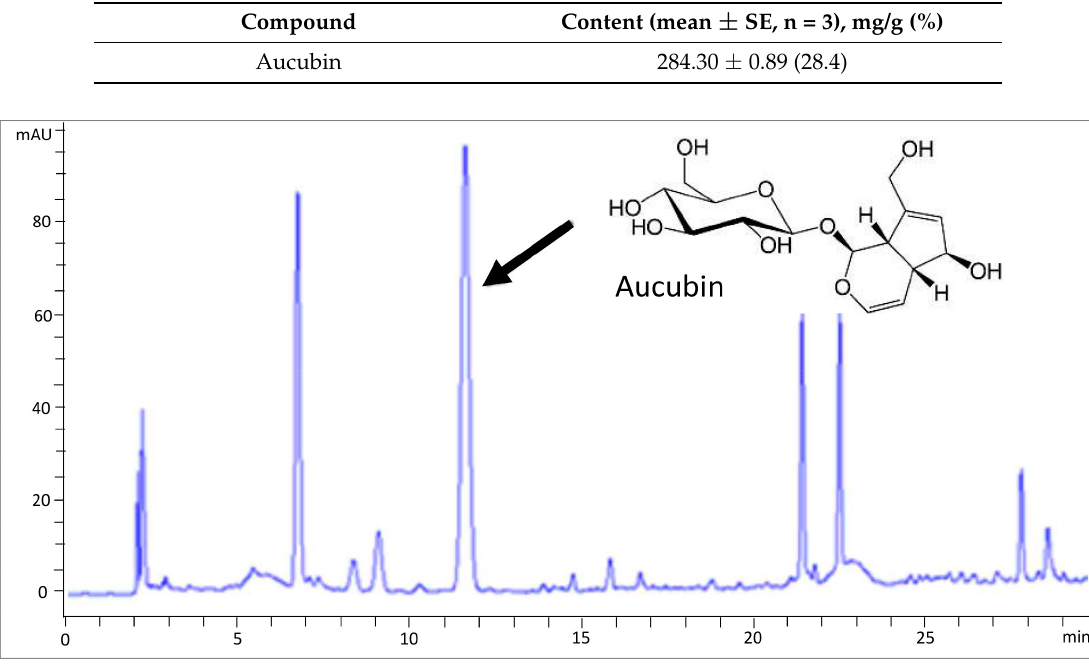
Figure 1. HPLC chromatographs of an extract of Aucuba japonica .